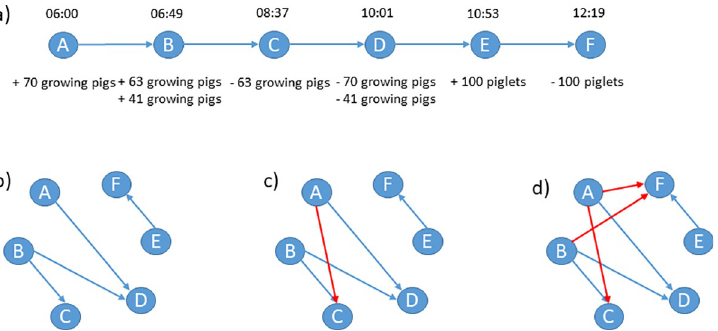
Fig 2. Example of transport data. (a) Time path of the transport data of one tour operated by a single truck. The tour starts at 6.00 a.m. at farm A where 70 pigs are loaded. It then continues to farm B where another 104 pigs are loaded. At farm C, some of the pigs from farm B are unloaded. After that, the truck continues to farm D where the pigs from farm A and the rest of the pigs from farm B are unloaded. The tour ends at 12.19 p.m. with a transport of 100 piglets from farm E to farm F. (b) The network corresponding to the direct transports between farms neglecting the transport sequence. (c) By taking the transport sequence into account, an additional edge between A and C is added because animals from farm A may transmit a disease to C via animals from B. (d) By assuming that the truck can be contaminated and transmit a disease even further, we must include another two edges between A and F and B and